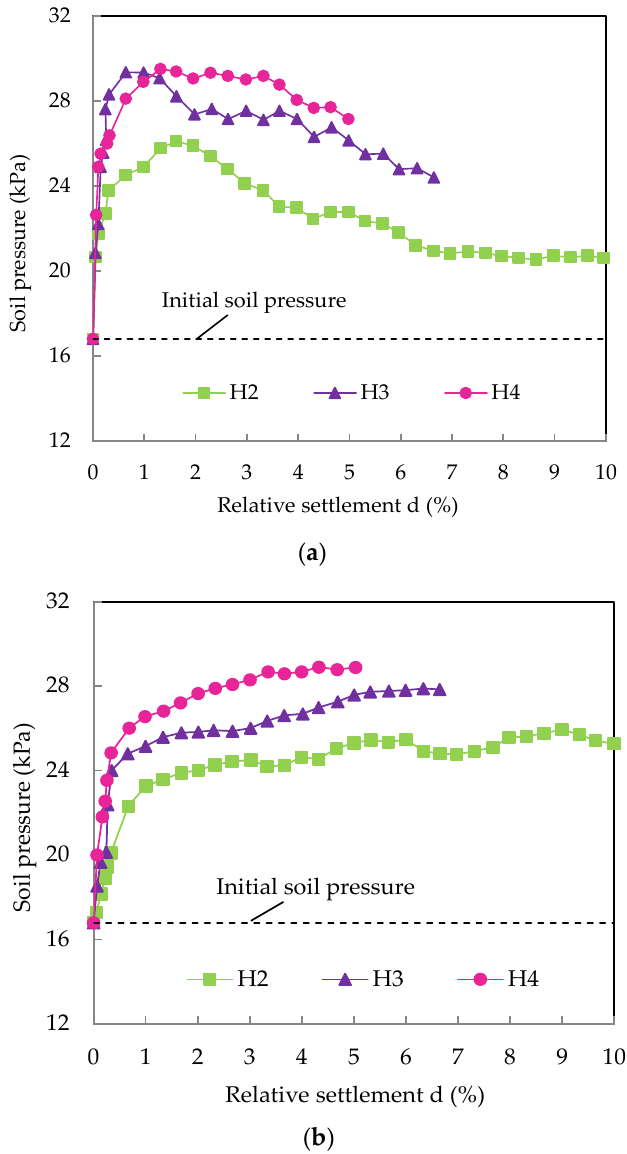
Figure 6. Change of soil pressure of the stable area: ( a ) soil pressure variation curve of the location of T3 with the relative settlement; ( b ) soil pressure variation curve of the location of T4 with the relative settlement.